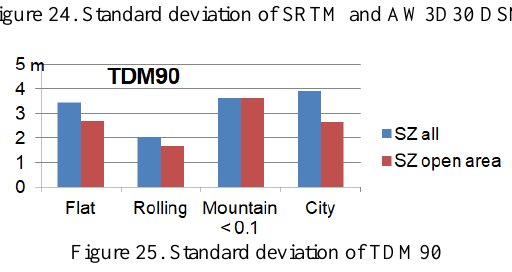
Figure 25. Standard deviation of